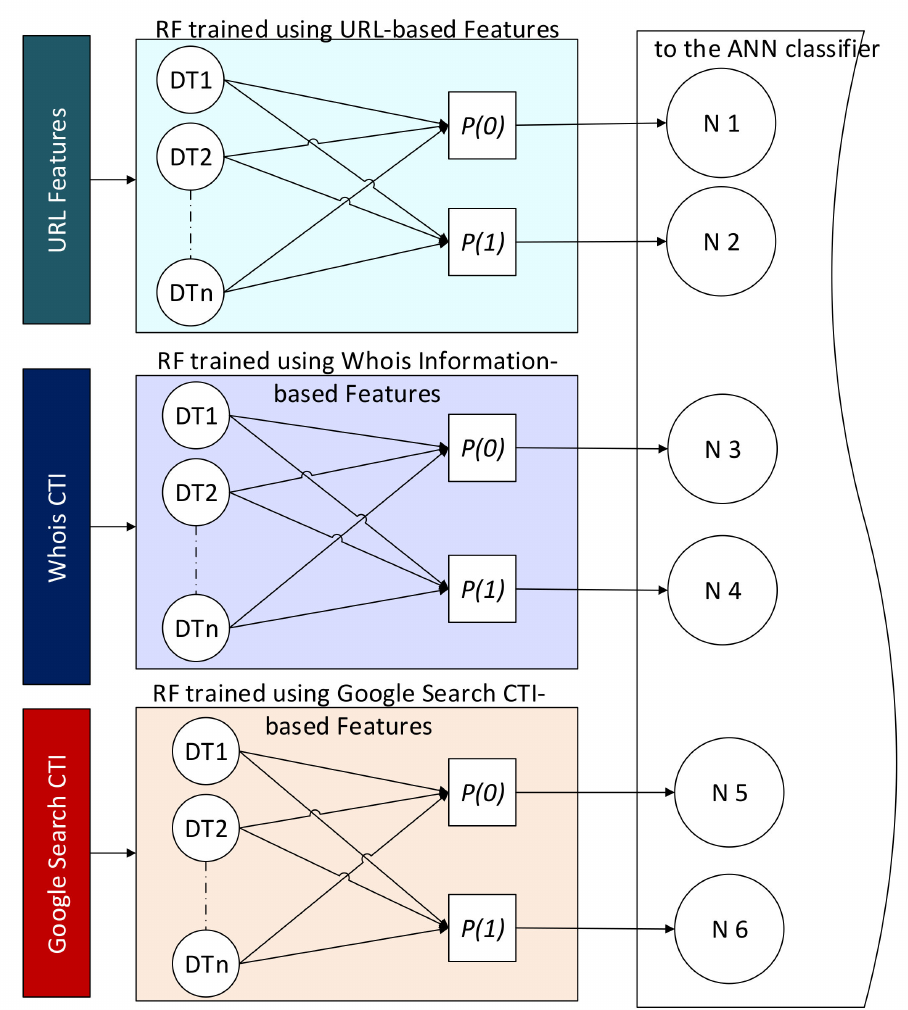
Figure 2. The new features extracted from the three ensemble